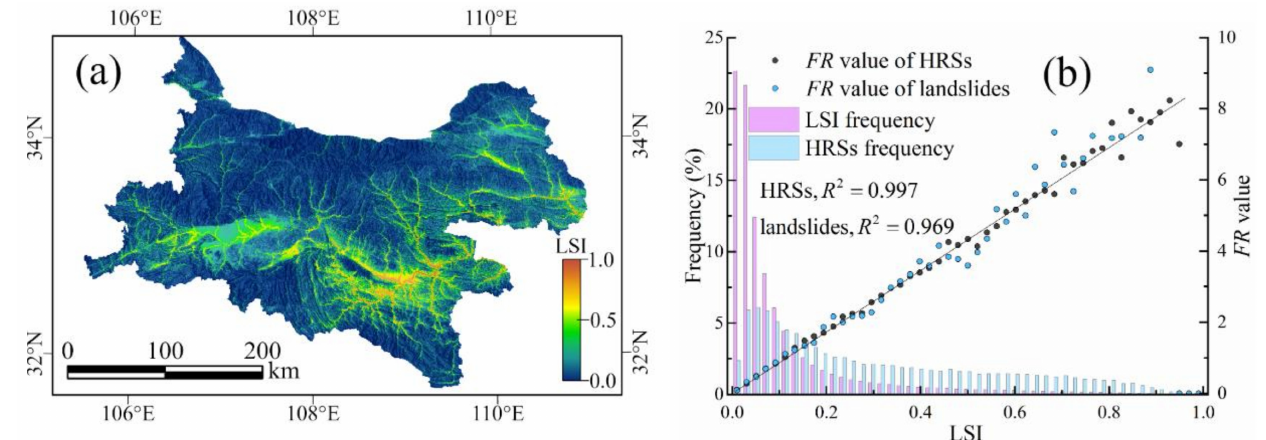
Figure 7. The corrected ANN model-based landslide susceptibility map, ( a ) corrected landslide susceptibility map, ( b ) statistical information of the corrected LSI.